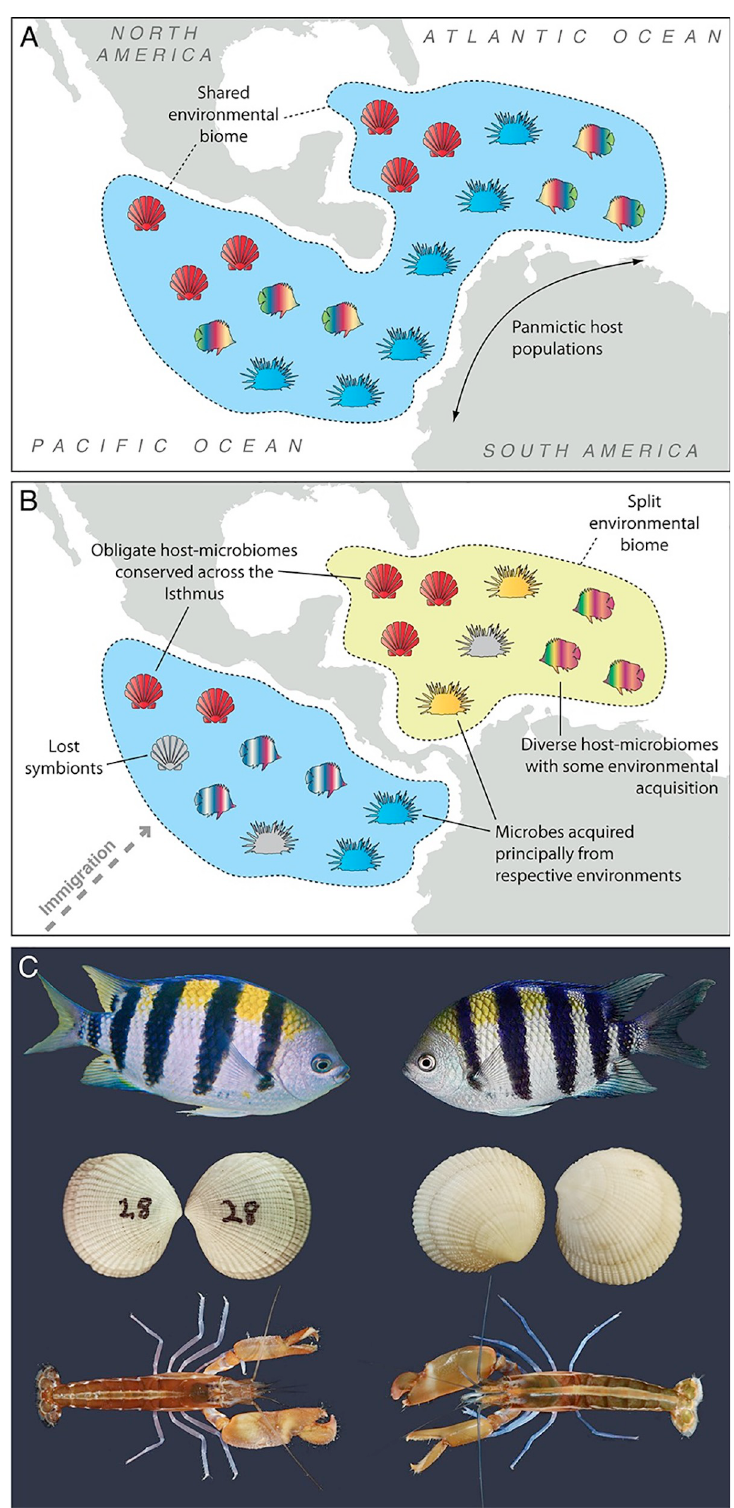
Fig 1. The formation of the Isthmus of Panama´ split an ocean into two, creating a natural experiment to explore general processes of host–microbe evolution. (A) Panmictic populations of hosts and their microbiomes living under similar environmental conditions became (B) physically isolated when the land bridge formed between North and